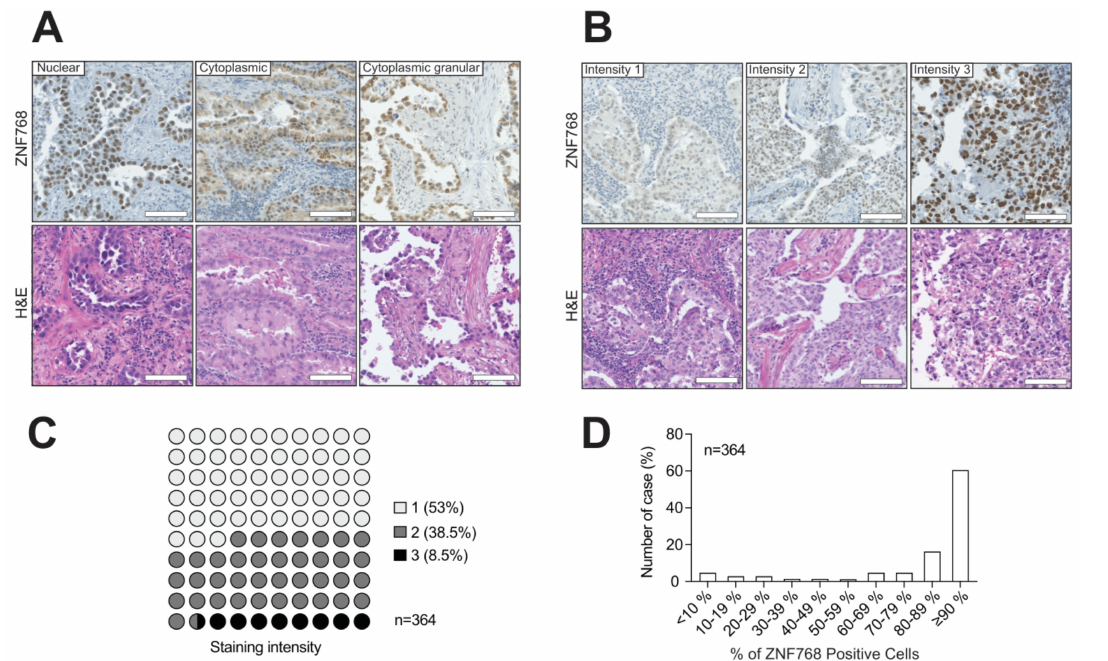
Figure 1. ZNF768 expression is often elevated in human LUAD. ( A ) Representative pictures of the different ZNF768 immunohistochemistry staining patterns in the tumors (nuclear–cytoplasmic-cytoplasmic granular) (magnification × 20, scale bar 100 µ m). ( B ) Example of the three-pronged scoring system (intensity 1-intensity 2-intensity 3) (magnification × 20, scale bar 100 µ m). ( C , D ) Distribution of the main staining intensity and the percentage of ZNF768 positive cells in the tumors of the